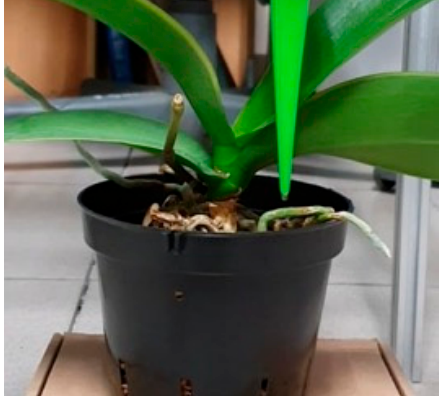
Figure 32. Demonstration of watering on the wrong position (collision of sprinkler with leaves).